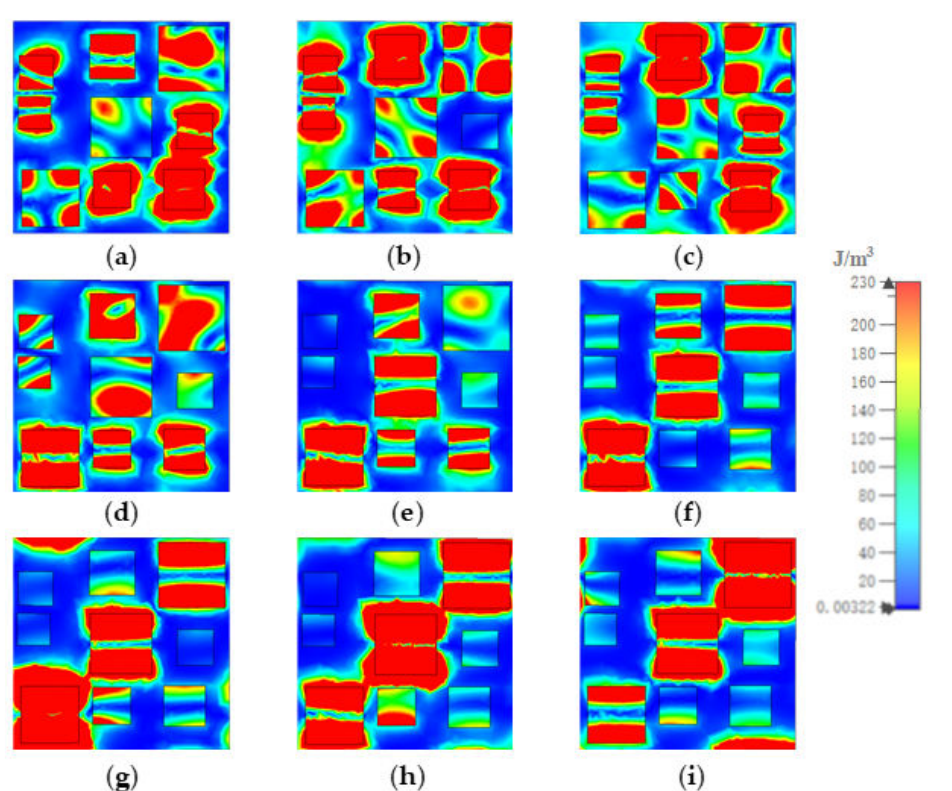
Figure 5. The distribution of electric field energy in gold substrate at ( a ) 8.5, ( b ) 9.13, ( c ) 9.88, ( d ) 10.86,